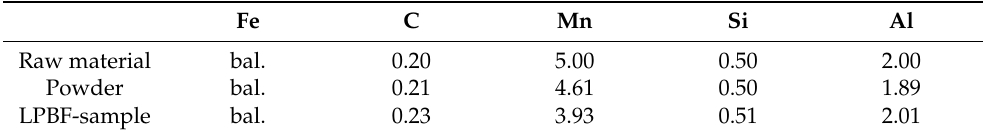
Table 2. The chemical composition of the raw material used for the gas atomization, the produced powder and samples fabricated by LPBF in wt.%. Fe C Mn Si Al Raw material bal. 0.20 Powder bal.